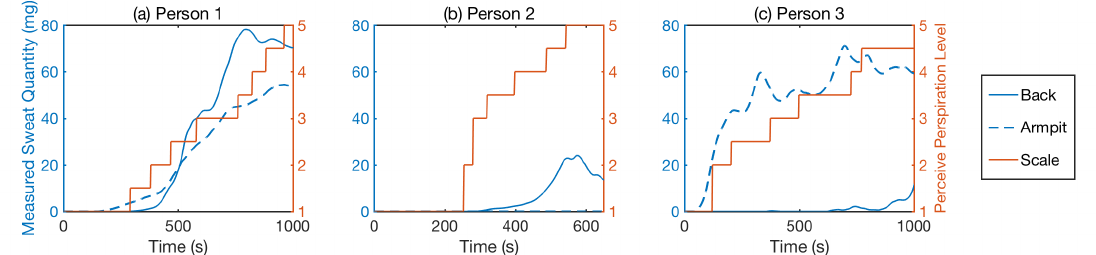
Figure 17. Perceived perspiration level based on people’s lived experience (( a – c ) represent three different people). The x-axis is the time from the moment they start to exercise until they stop. The solid blue lines are the measured sweat quantity (mg) for the sensor on the back. Blue dash lines are the measured sweat quantity (ms) for the sensor at the armpit. The red line is their perceived perspiration level, as listed in Table 2